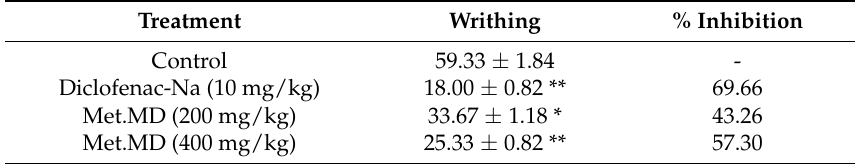
Table 1. Antinociceptive effect of methanol extract of M. denticulata leaves in acetic acid-induced abdominal writhing test in mice.